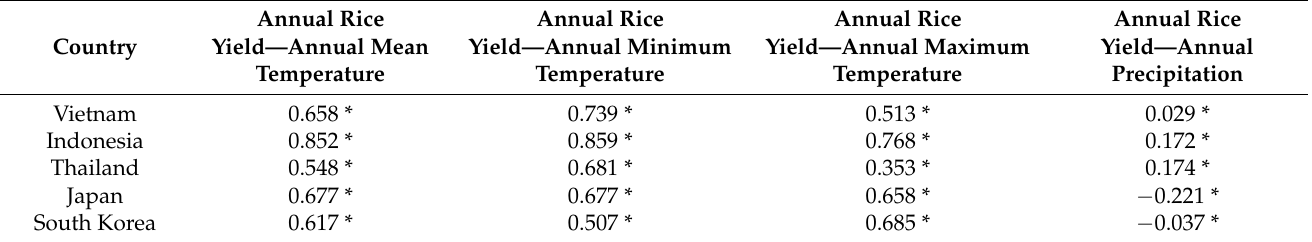
Table 11. In the five selected countries, the annual rice yield positively correlates with annual mean, annual minimum, and annual maximum temperatures. As for precipitation, the relationship of annual rice yield and annual precipitation in the selected countries differs. In low latitude countries (Vietnam, Indonesia, and Thailand), the annual rice yield weakly positively correlates with annual precipitation, while in high latitude countries (Japan and South Korea) they correlate with each other negatively. Table 11. Correlation coefficients of climate indicators (annual mean, annual maximum, annual minimum air temperature, and annual precipitation) and annual rice yield in Vietnam, Indonesia, Thailand, Japan, and South Korea. (Source: data retrieved from [4,84]).